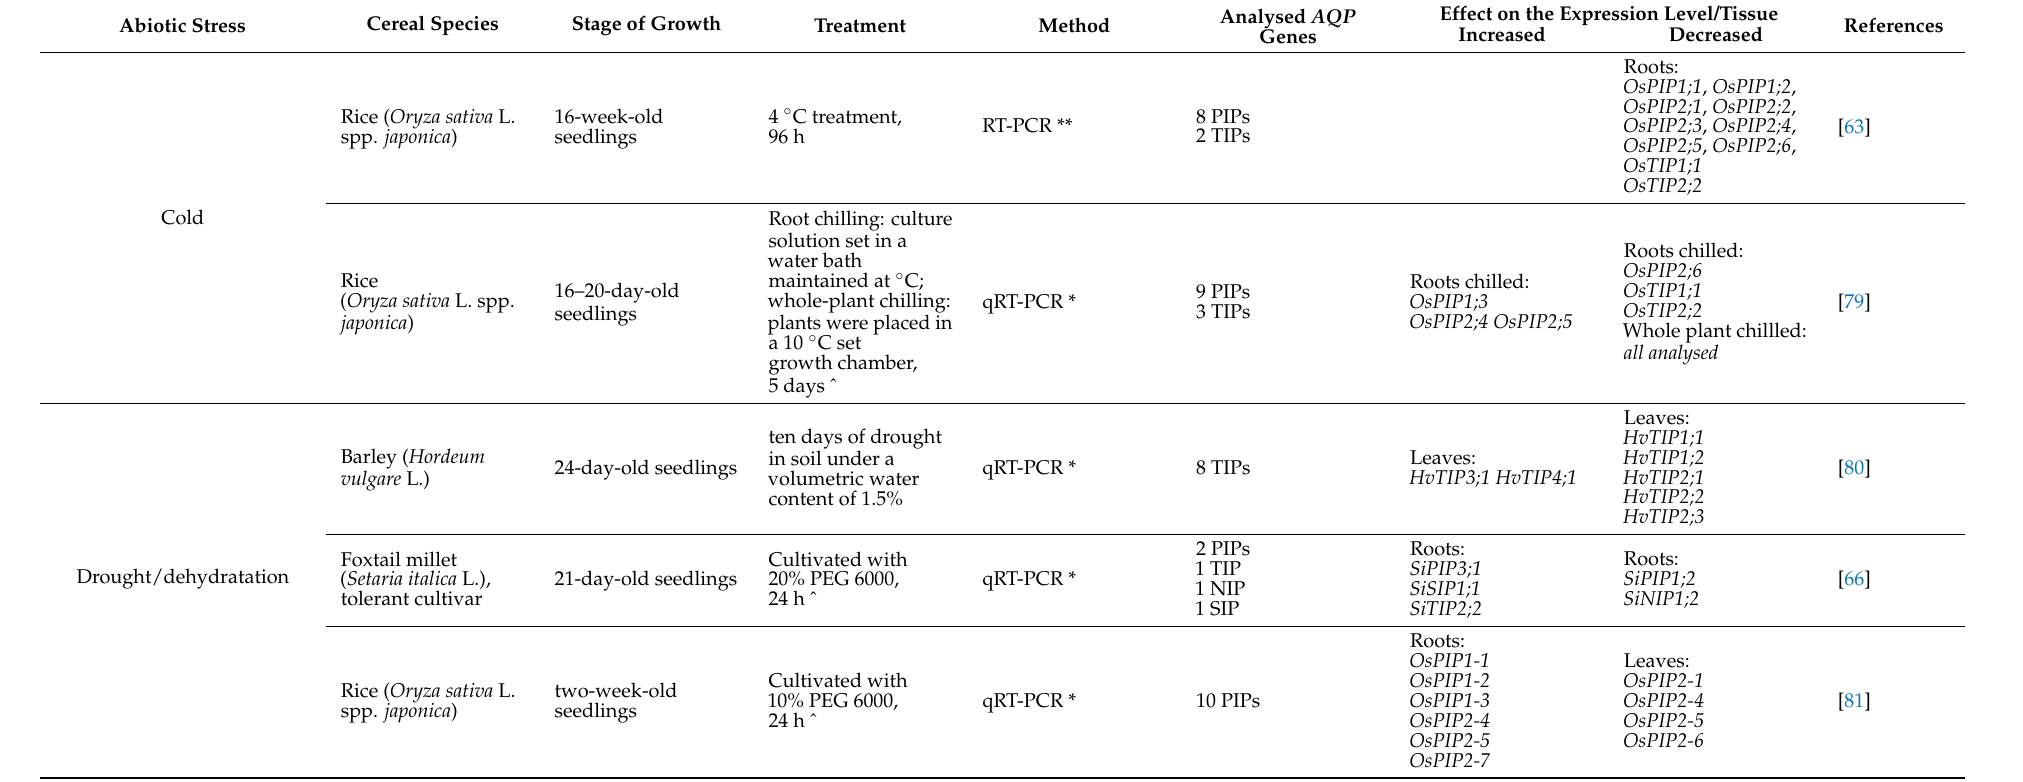
Table 2. Study of the expression the AQP genes in cereal species under abiotic